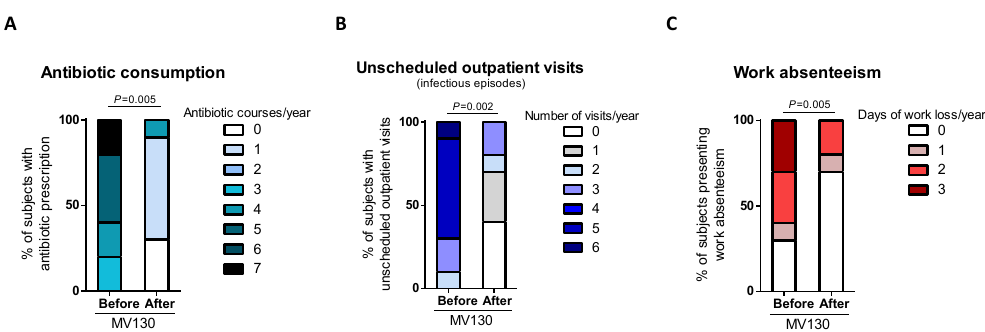
free of infection (grey) or suffered recurrences (red) in the 12 months following MV130 administration. Data from 10 subjects are shown. ( B ) Lines link paired values. Normal distribution was evaluated using the Shapiro – Wilk test, P value was calculated using Wilcoxon signed-rank test. ( C ) p value was calculated using Fischer’s exact test, compared with rates prior to MV130 initiation (100% of subjects suffering infections).